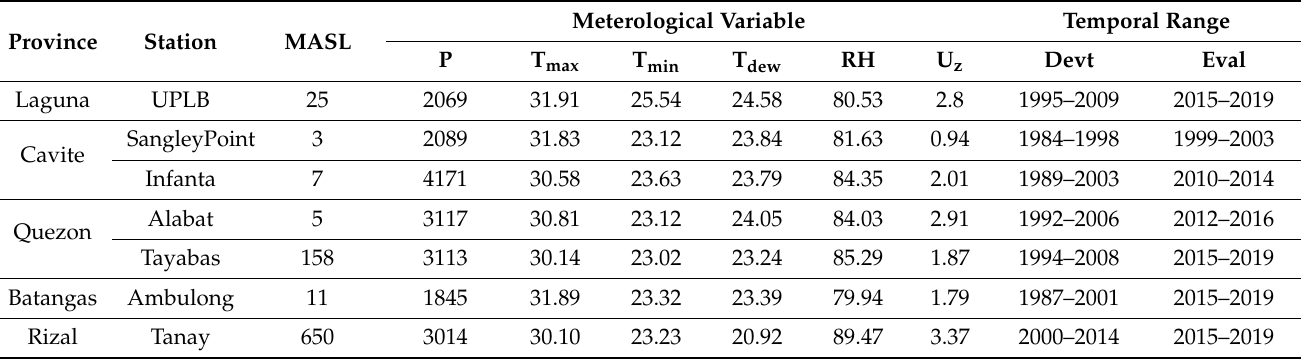
Table 1. Temporal coverage of records and annual mean values of meteorological data of seven stations in Region IV-A.